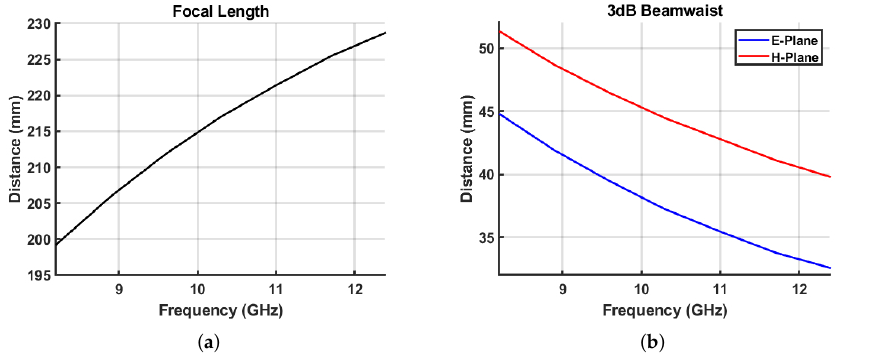
Figure 4. Characteristics of the focused-beam lens horn antenna. ( a ) Focal Length. ( b ) 3 dB Beamwaist.